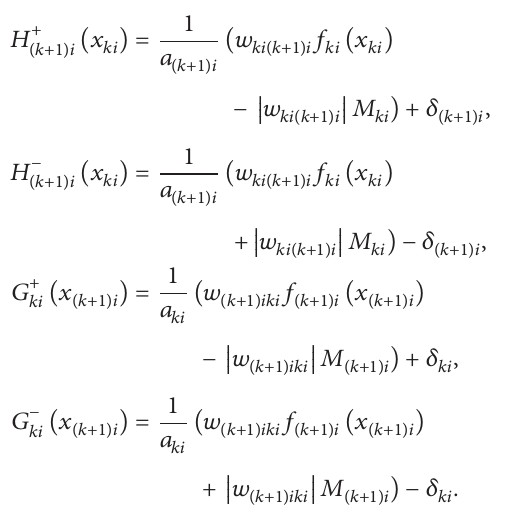
For any 𝑘 ∈ 𝐼 𝑀 , 1 ≤ 𝑖 ≤ 𝑙 𝑘 , define 𝐻 + (𝑥 ) 𝑘𝑖 (𝑘+1)𝑖